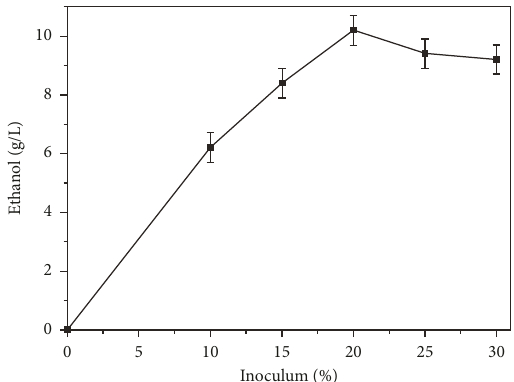
Figure 6: The effect of inoculum on ethanol formation.